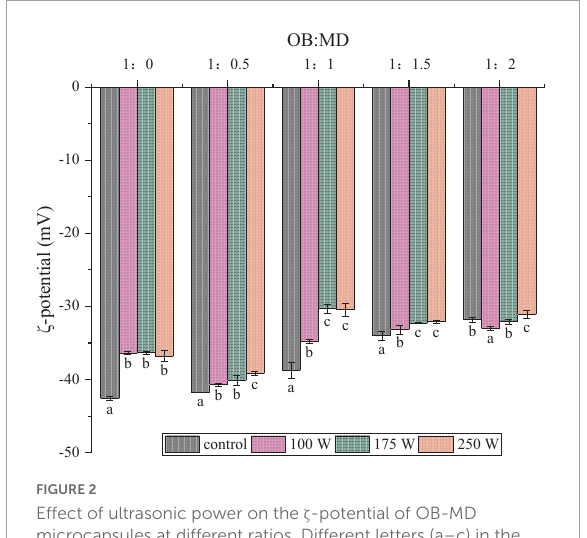
FIGURE2 Effect of ultrasonic power on the ζ -potential of OB-MD microcapsules at different ratios. Different letters (a–c) in the figure indicate significant differences ( P <